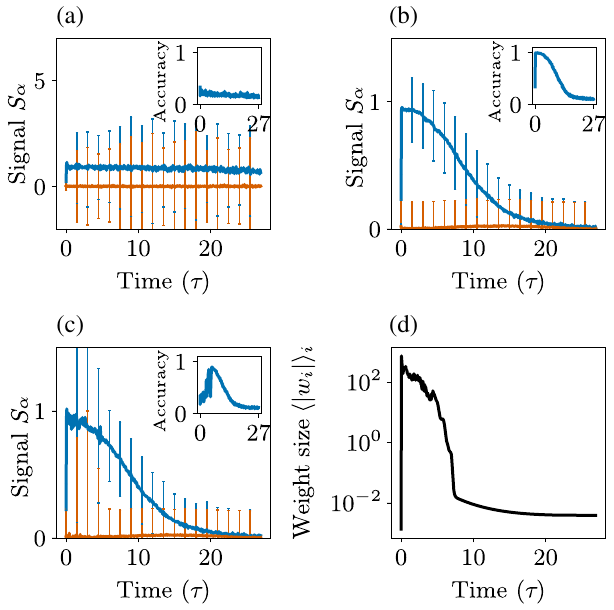
FIG. 10. Stimulus representation in a rate network. (a) – (c) Signal of correct readout (blue), signal of wrong readouts (dark orange), and classification accuracy (inset). (a) Including noise σ 2 ξ matched to the statistics of a binary network according to Eq. (22). Parameters otherwise as in Fig. 9. Because the frozen effective noise suppresses chaos, trajectories for different stimuli converge toward the same state, and a small readout noise σ 10 − 4 results in classification at chance level. (b) Re- readout ¼ moving the noise in the network, and no readout noise. The network is chaotic as in Fig. 9, and classification accuracy jumps to 1 in the first time step. (c) Including readout noise σ readout ¼ 10 − 4 impedes classification accuracy until trajectories are suffi- ciently separated. (d) Average norm of individual readout weights for the setting in (b). Since trajectories are very close in the initial time period [compare also Fig. 9(b)], initial readout weights are very large, explaining the sensitivity to readout noise in (c).